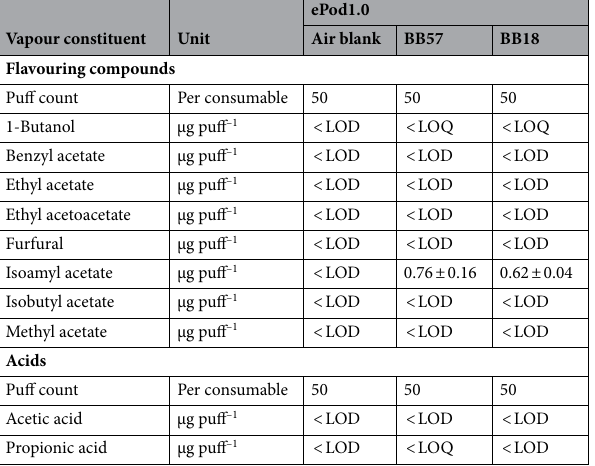
Table 5. Flavouring compounds and acids: Per-puff concentration of e-cigarette vapour emissions and respective method air blanks. Values are presented as mean ± standard deviation (n = 5). LOD limit of detection, LOQ limit of quantification. More information about the analytical methods and respective LODs and LOQs are under the Supplementary Information (Tables S1 and